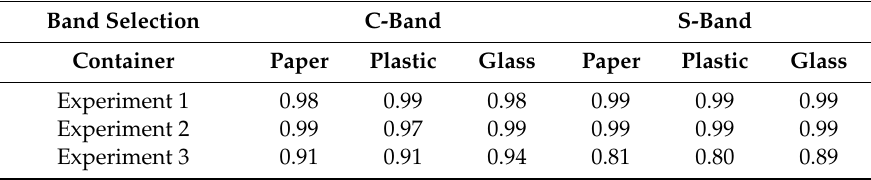
Table 2. The KNN algorithm classification results of the system.